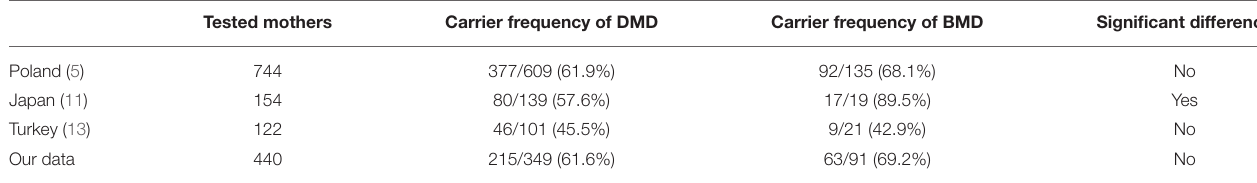
TABLE 3 | Comparison of carrier frequencies of DMD and BMD in different countries.